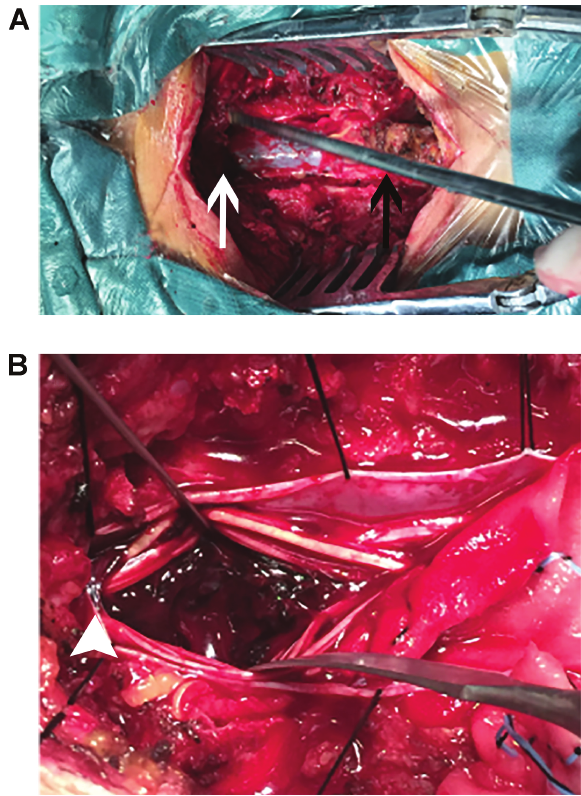
Figure 2: Laminectomy from the lower segment (S1, black arrow) upward to L4 (white arrow) with tight dural stretch and subdural bluish color (A) and extended to L3 (white arrow head) with subdural hematoma (B) (from left to right indicates the direction from the rostral to the caudal